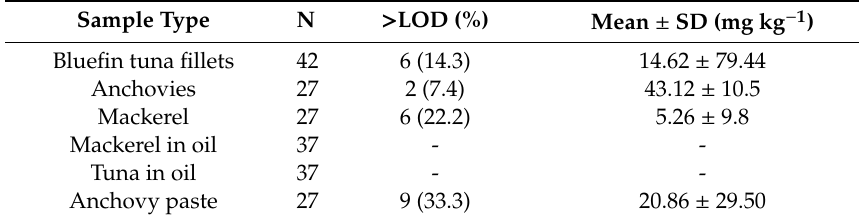
Table 2. Fresh and processed fish samples analyzed by the validation process. LOD: limit of